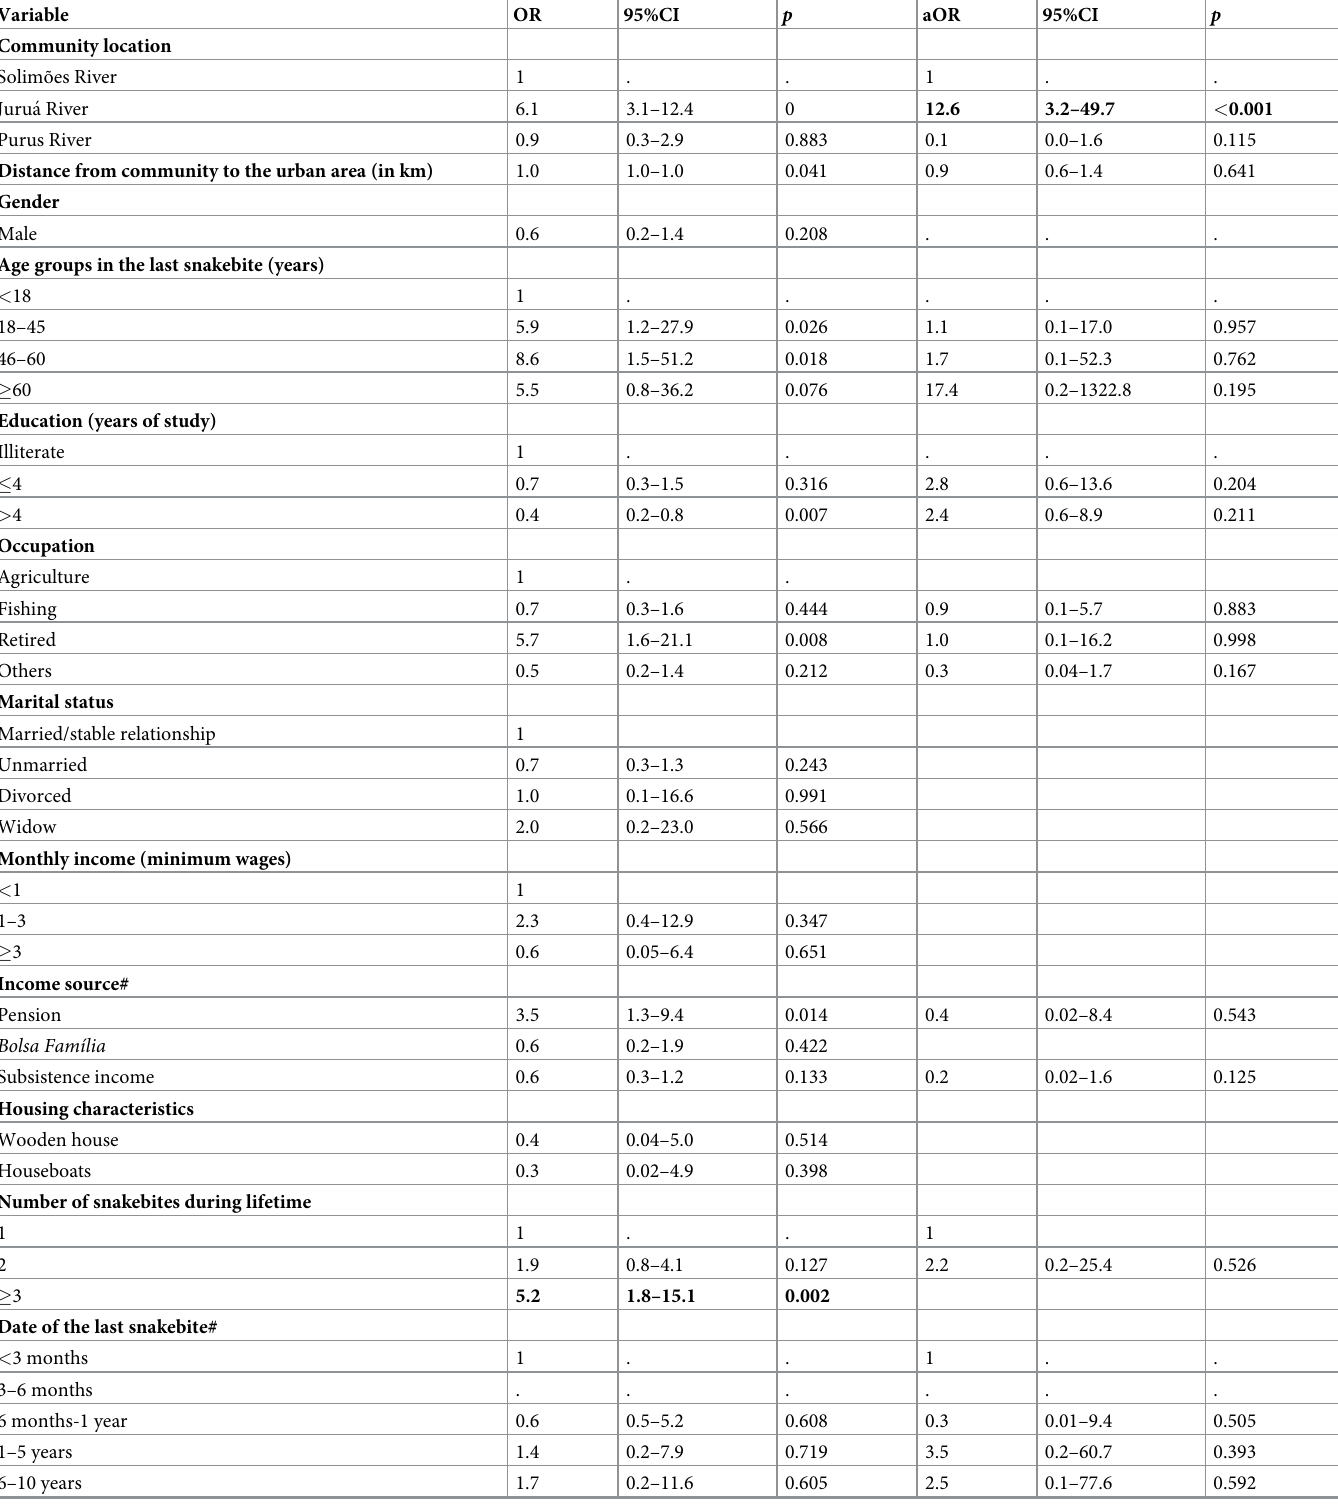
Table 3. Factors associated to access to lack of healthcare in participants living in three river basins, western Brazilian